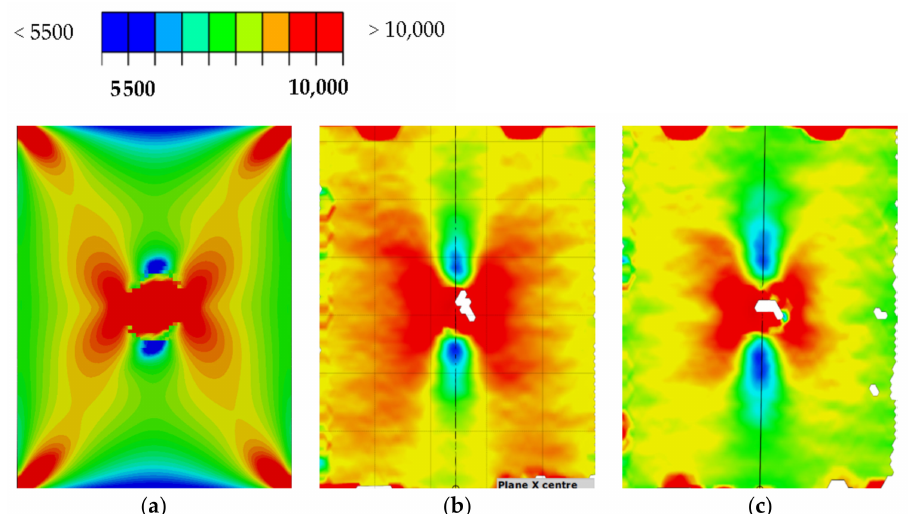
Figure 17. Max. principal strain distribution ( µ m/m) at load 110 kN; ( a ) Simulation; ( b ) Experiment sample 1; ( c ) Experiment sample 2.